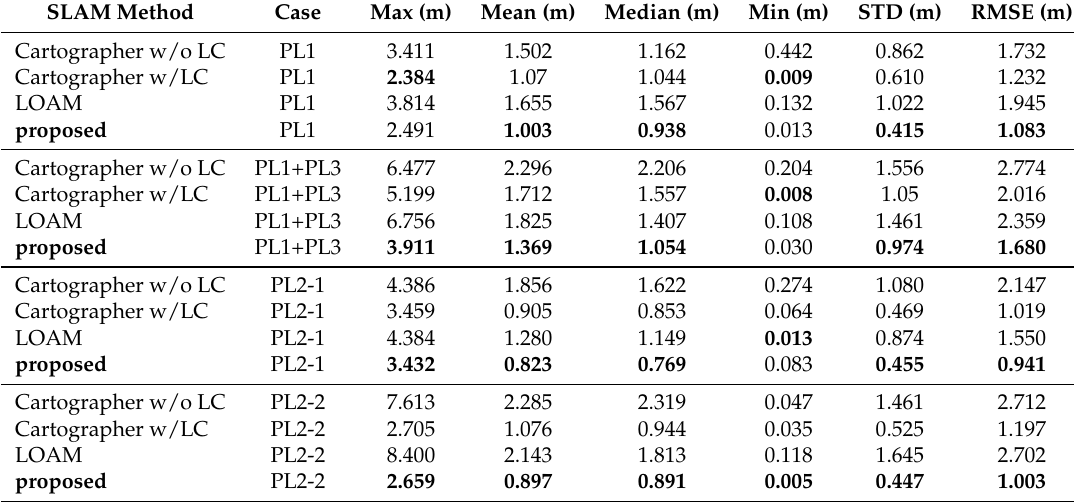
Table 1. Experimental result of absolute trajectory error. Parking lot (PL), loop closing (LC), standard deviation (STD), root mean square error (RMSE). Bold values mean the smallest value achieved among the